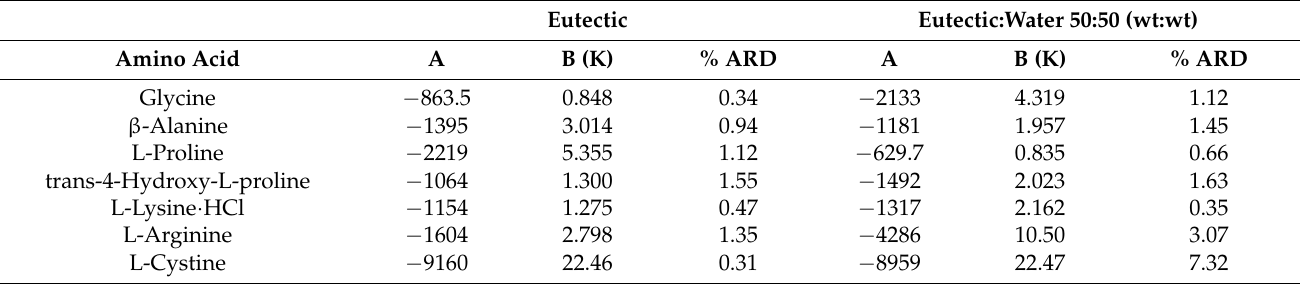
Table 4. Regression parameters of the van ‘t Hoff model obtained from the correlation of the natural logarithm of the experimental solubility data with the inverse of the absolute